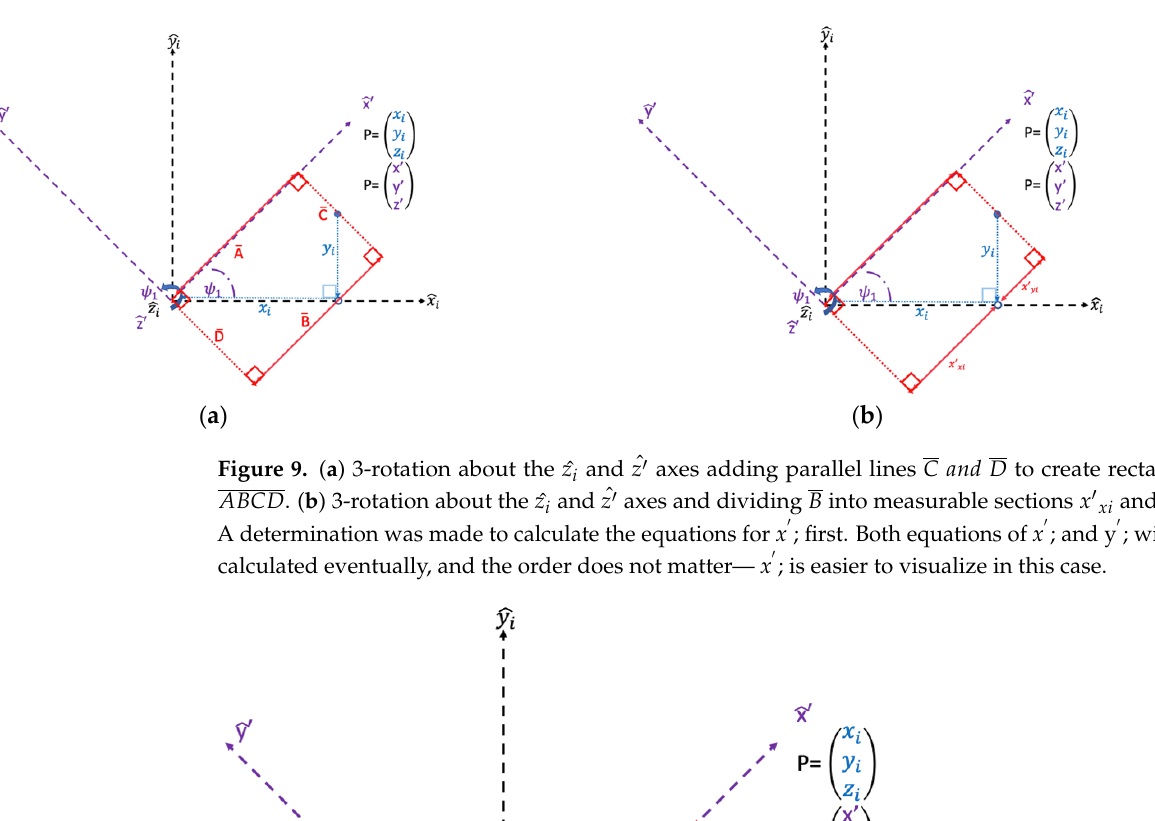
Figure 8. ( a ) 3-rotation about the 𝑧 𝑖 ̂ and 𝑧′̂ axes with the line 𝐴̅ equivalent to x’; ( b ) 3-rotation about the 𝑧 𝑖 ̂ and 𝑧′̂ axes with parallel lines 𝐴̅ 𝑎𝑛𝑑 𝐵̅ equivalent to x’.